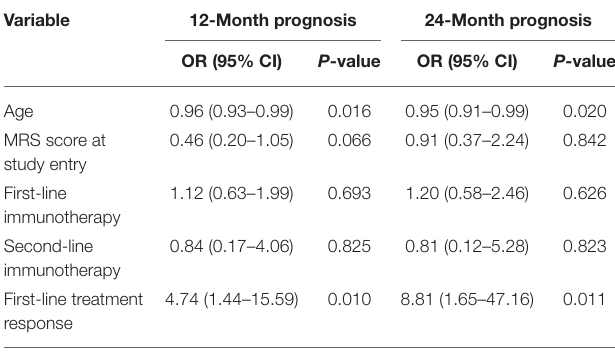
TABLE 4 | Univariate analysis of factors associated with poor prognosis in patients with AE.